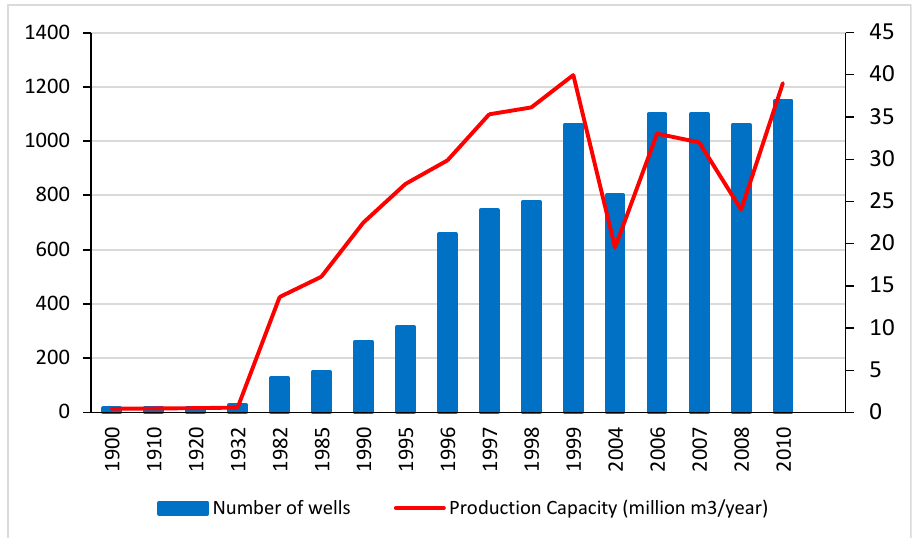
Figure 2. Number of the registered deep wells and their production capacity in Semarang City.